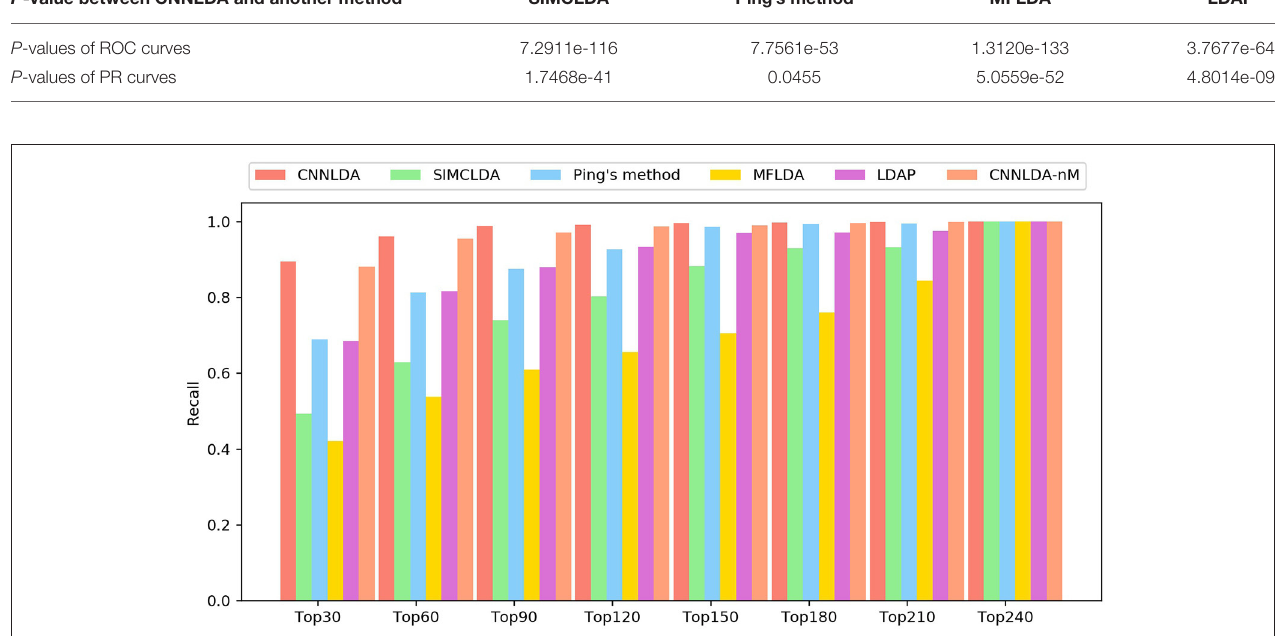
TABLE 3 | A pairwise comparison with a paired Wilcoxon-test on the prediction results in terms of AUCs and AUPRs. P -value between CNNLDA and another method